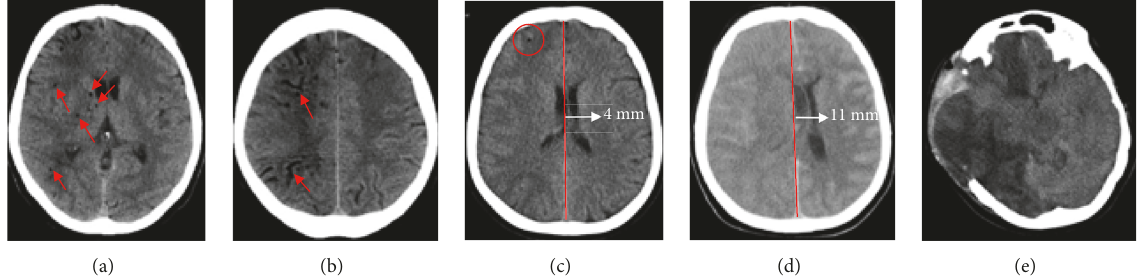
Figure 3: Head CT scan: (a) before HBOT: gas bubbles in the basal nuclei and (b) within the subarachnoid spaces (arrows); (c) immediately after HBOT: single right frontal bubble (circle) and 4 mm: leftward deviation of the midline (arrow); (d) 14 hours after HBOT 4 mm: leftward deviation of the midline; (e) 5 days after right decompressive craniectomy: massive brain herniation with right hemispheric and left frontal ischemia.